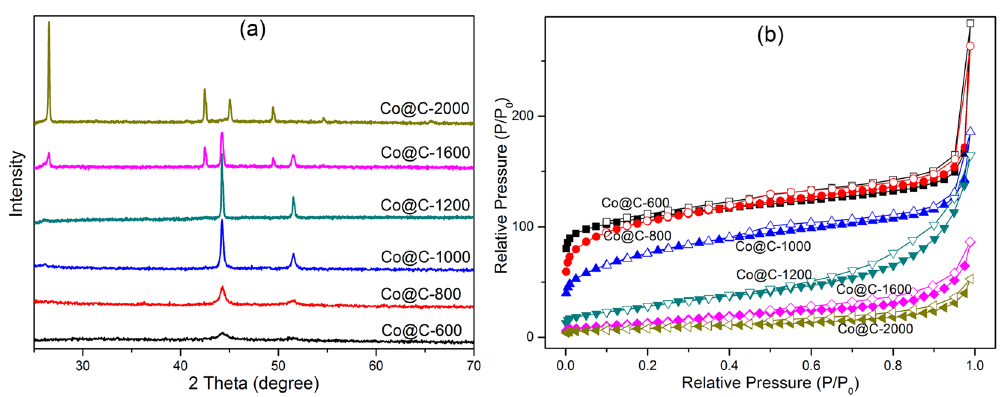
Figure 3. ( a ) XRD patterns, and ( b ) Nitrogen adsorption-desorption isotherm curves of the as-synthesized Co@C